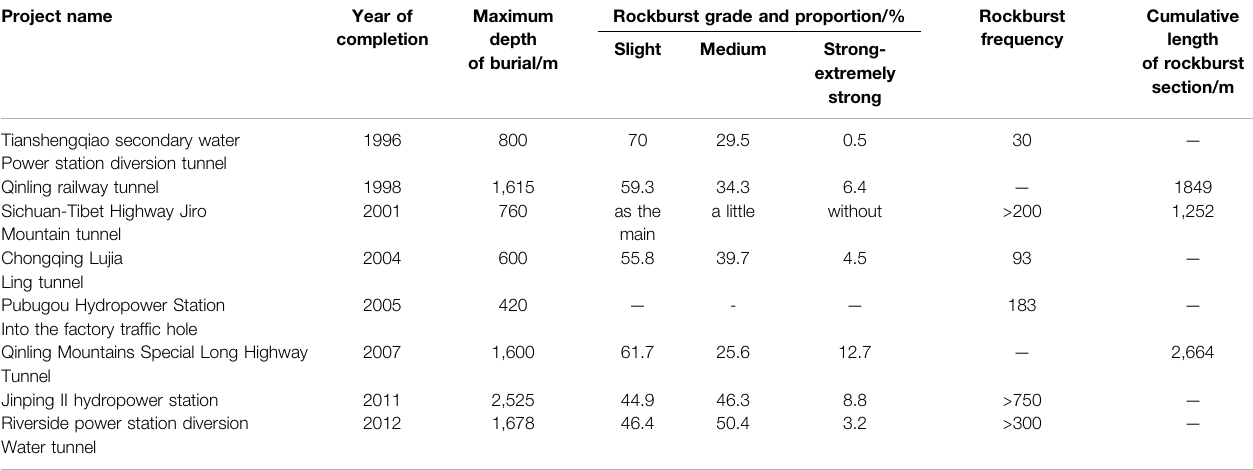
TABLE 1 | Incomplete statistical of rockbursts record in tunnel engineering in China (Feng et al.,